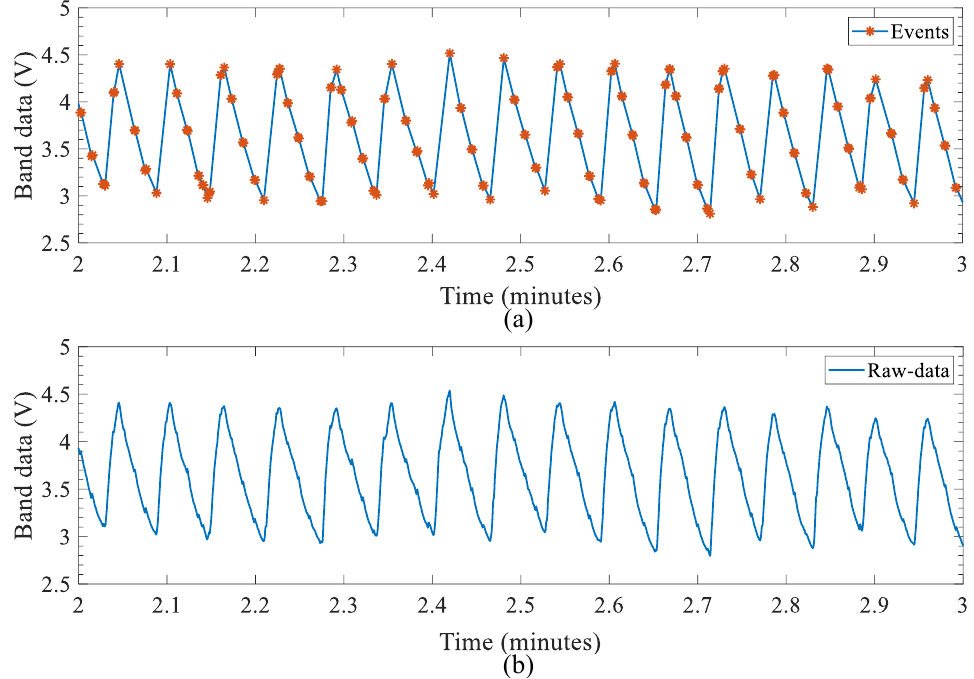
Figure 13. One-minute window of the data set showing the original waveform reconstructed using event-based data. ( a ) Waveform reconstructed using the event data. ( b ) Raw-data